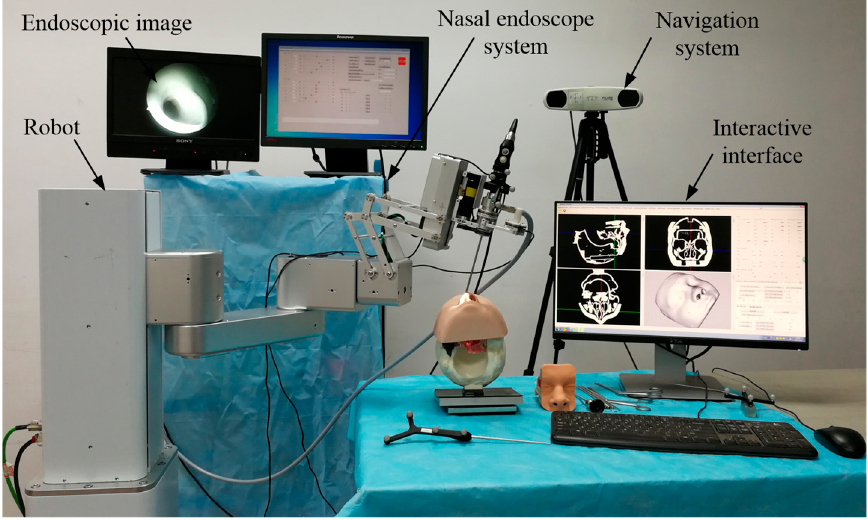
Figure 9. Endoscopic sinus surgery assistant robot system.